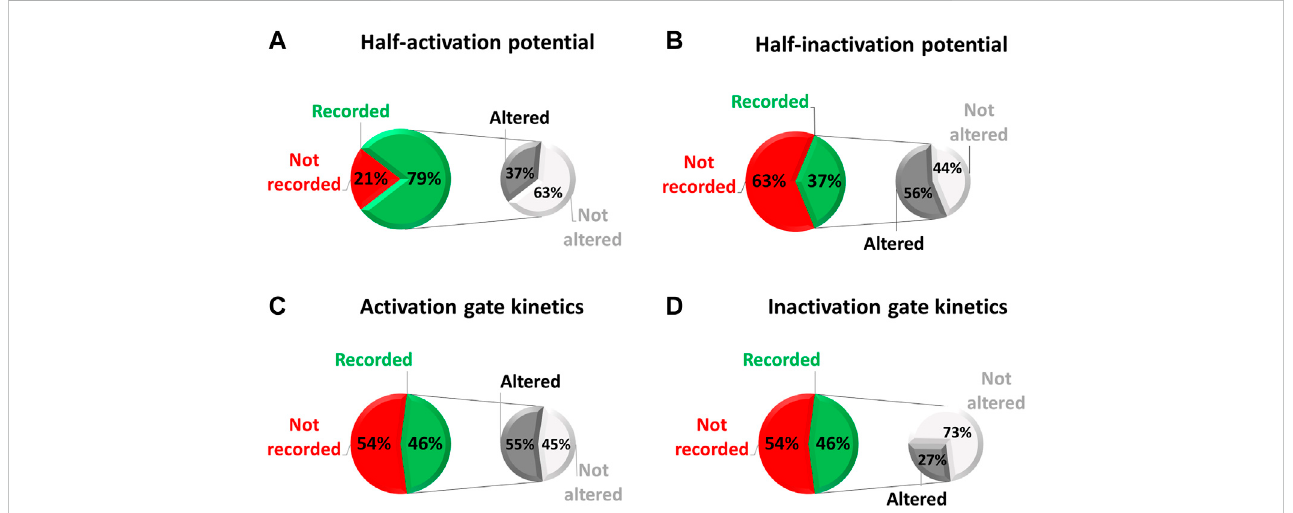
FIGURE 4 Piechartpresenting,amongthemissensevariantsreferencedintheFrenchnetworkCARDIOGEN( n =112)andstudiedinelectrophysiology( n =38),the percentageofwhichhalf-activationpotential (A) ,half-inactivationpotential (B) ,activationgatekinetics (C) ,andinactivationgatekinetics (D) werestudied,and when studied, the percentage of variants showing an alteration of the given parameter (from analysis of Supplemental Table